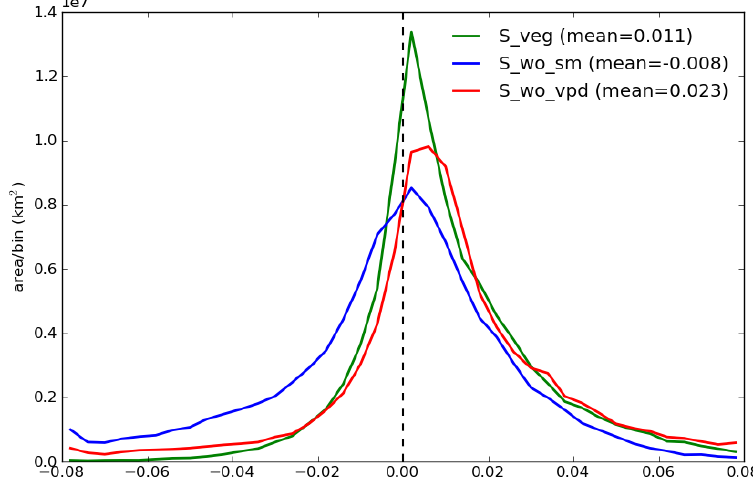
Figure 5. Histograms of the differences between 2000–2009 Gross Primary Production (GPP) and 1982–1999 GPP for the GIMMS-3g driven simulation ( S_veg ), without-soil moisture simulation ( S_wo_sm ), and without-VPD (Vapor Pressure Deficit) simulation ( S_wo_vpd ). The maps of the differences are shown in Figure 3(b), Figure 4(c,d), respectively. The means in the legend are mean value of the difference for each